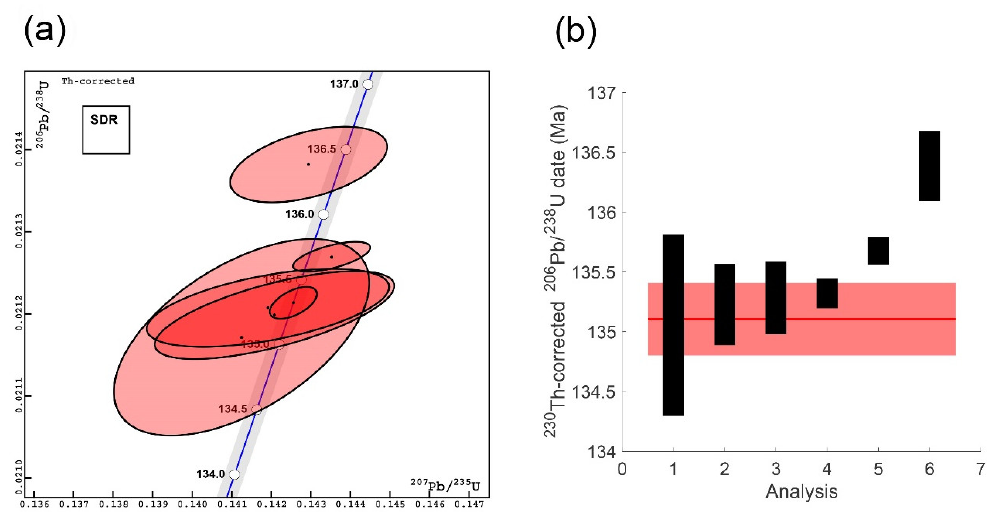
Figure 6. U-Pb CA-ID-TIMS data for sample SDR 36.35. ( a ) Plot showing 2 σ uncertainty ellipses for the six zircon analyses in Table 2. The blue line is concordia, the gray shaded region is the 2 σ uncertainty defined by the 238 U and 235 U decay constant uncertainties, and all data have been corrected for initial 230 Th disequilibrium. ( b ) Age-rank plot of analyzed zircon dates. Black boxes illustrate ± 2 σ analytical uncertainties, and the red-shaded region is the calculated best estimate of the eruption and maximum depositional age using the algorithm of Keller et al. [20]. See Table 2 for data.